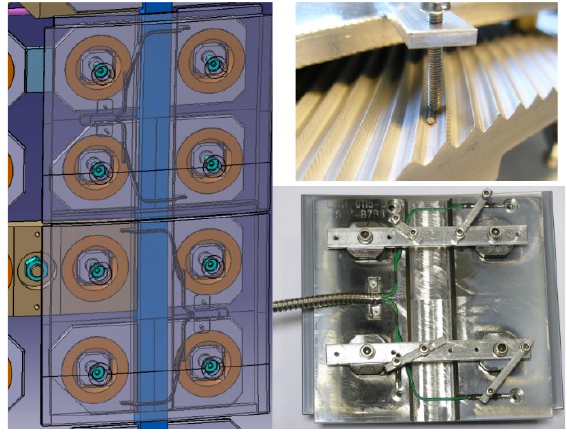
Fig. 6. Left: Transparent CAD view of two double tiles with built-in channels for the cables. Right: Tools which ensure a precise flush mount. During the attachment procedure, the opening of the borehole at the plasma exposed surface is temporarily blocked (upper right photo). This opening is normally located on the bottom of a groove of the grating. The view onto the rear side (lower right) shows the mechanics used to fixate cables and cylindrical joints.